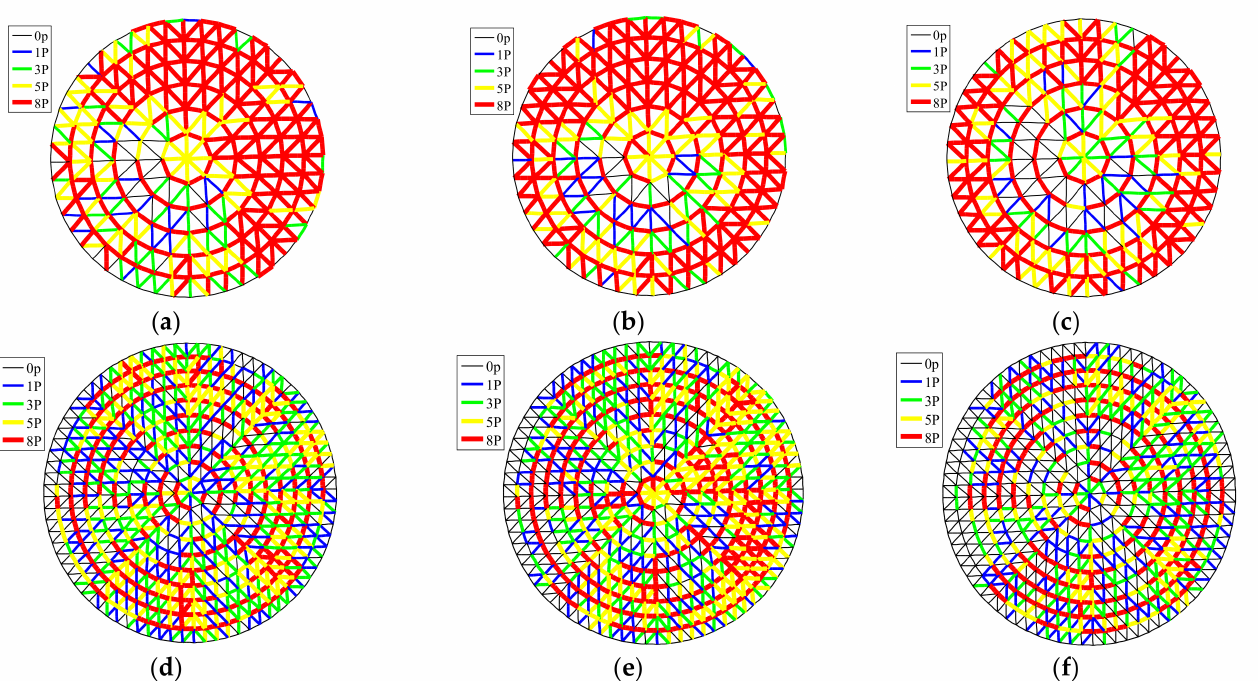
Figure 7. Distributions of the plastic shell member in the shell with various roofing systems: ( a ) D4053- W 2000 cm/s 2 ; ( b ) D4053-LSWM 2200 cm/s 2 ; ( c ) D4053-HHWM 2200 cm/s 2 ; ( d ) D8073-W 1800 cm/s 2 ; ( e ) D8073-LSWM 1800 cm/s 2 ; ( f ) D8073-HHWM 1800 cm/s 2